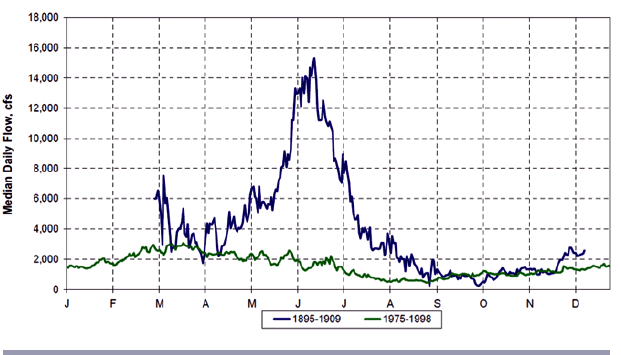
Fig. 1 . Median daily flows of the Platte River at Duncan, Nebraska, ∼ 69 km east of the central Platte River, in 1895-1909 and 1975-1998. Source: U.S. Department of the Interior (2006 a